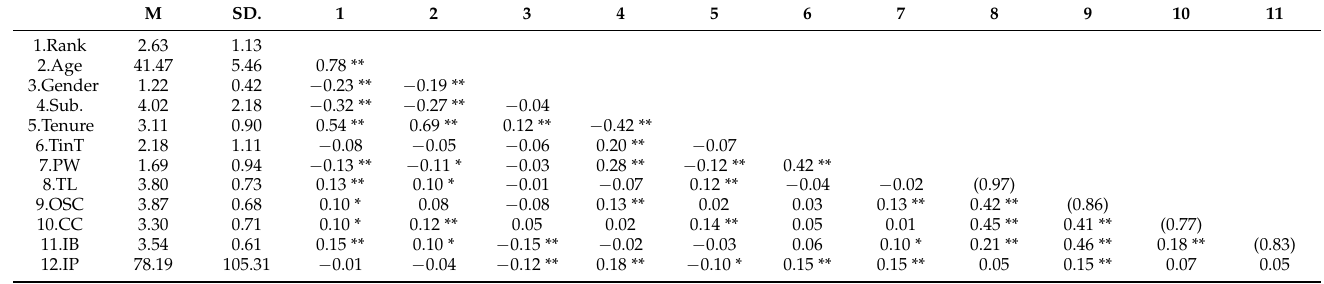
Table 2. Descriptive statistics, correlations, and reliability.